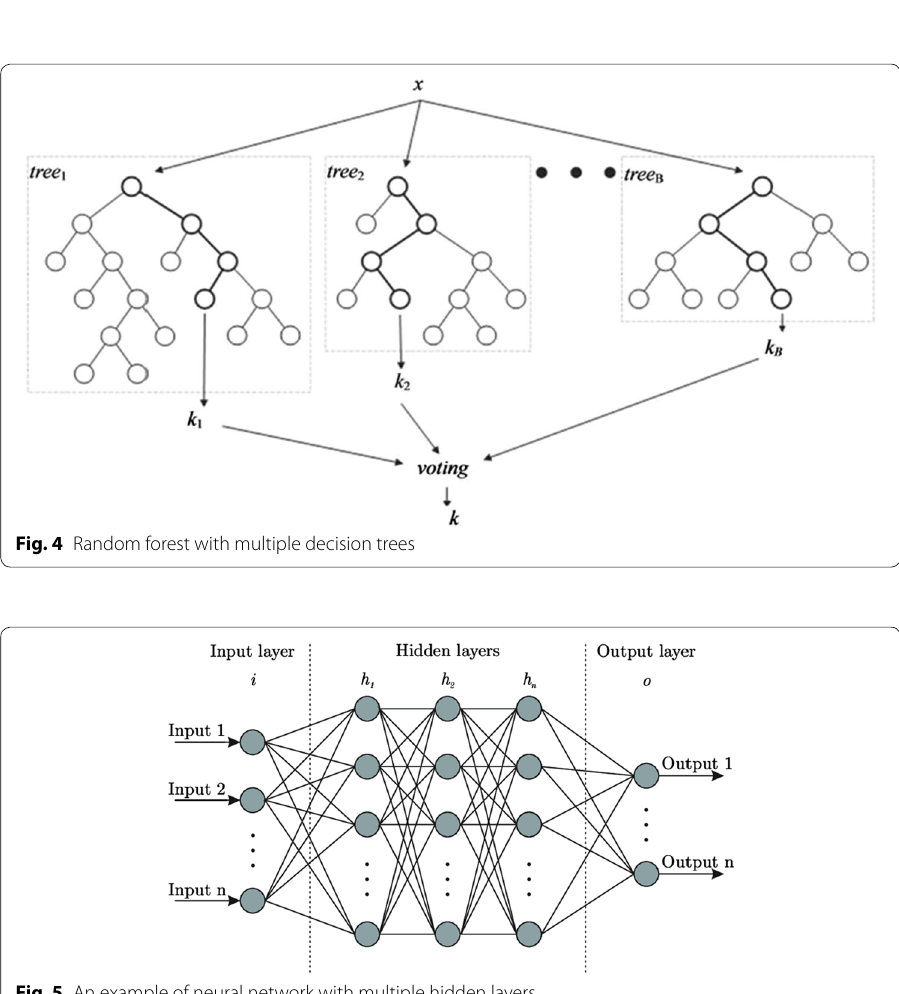
Fig. 5 An example of neural network with multiple hidden